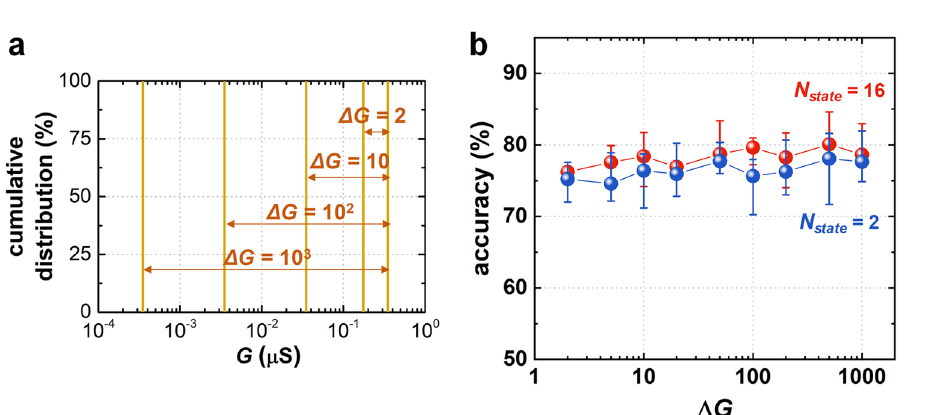
Figure 3. ( a ) The distribution of synaptic device conductance ( G ) in the BNN with different Δ G . It is assumed that there is no device-to-device variation, that is, all synaptic devices in the simulation have equivalent G high and G low values. ( b ) The simulated accuracy as a function of Δ G , which is obtained by repeating the simulation 10